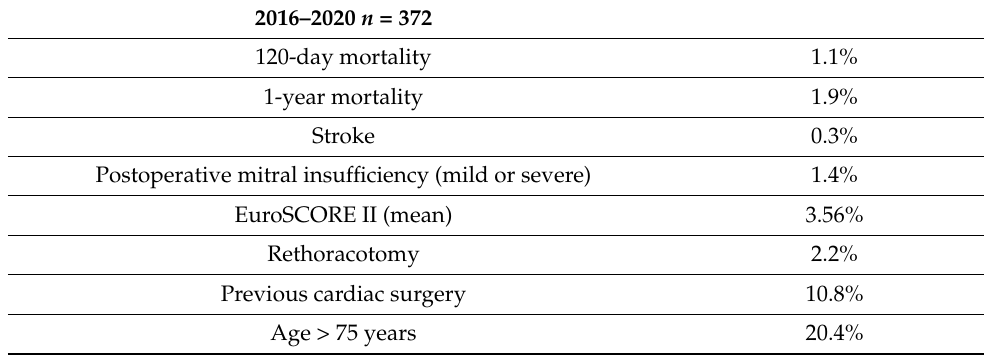
Table 1. Summary of perioperative variables in the MIMVS isolated mitral group.